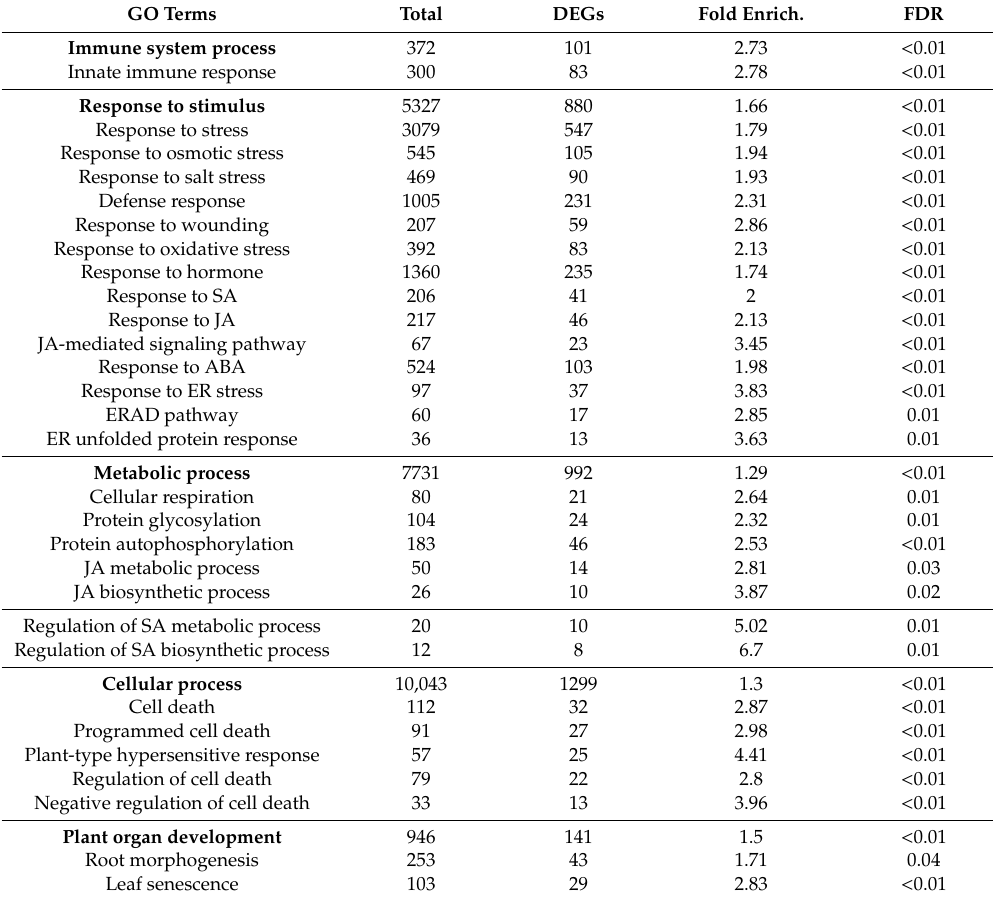
Table 1. Selected GO terms (biological process) for upregulated genes in i-hpHSP90C transgenic line after Dex